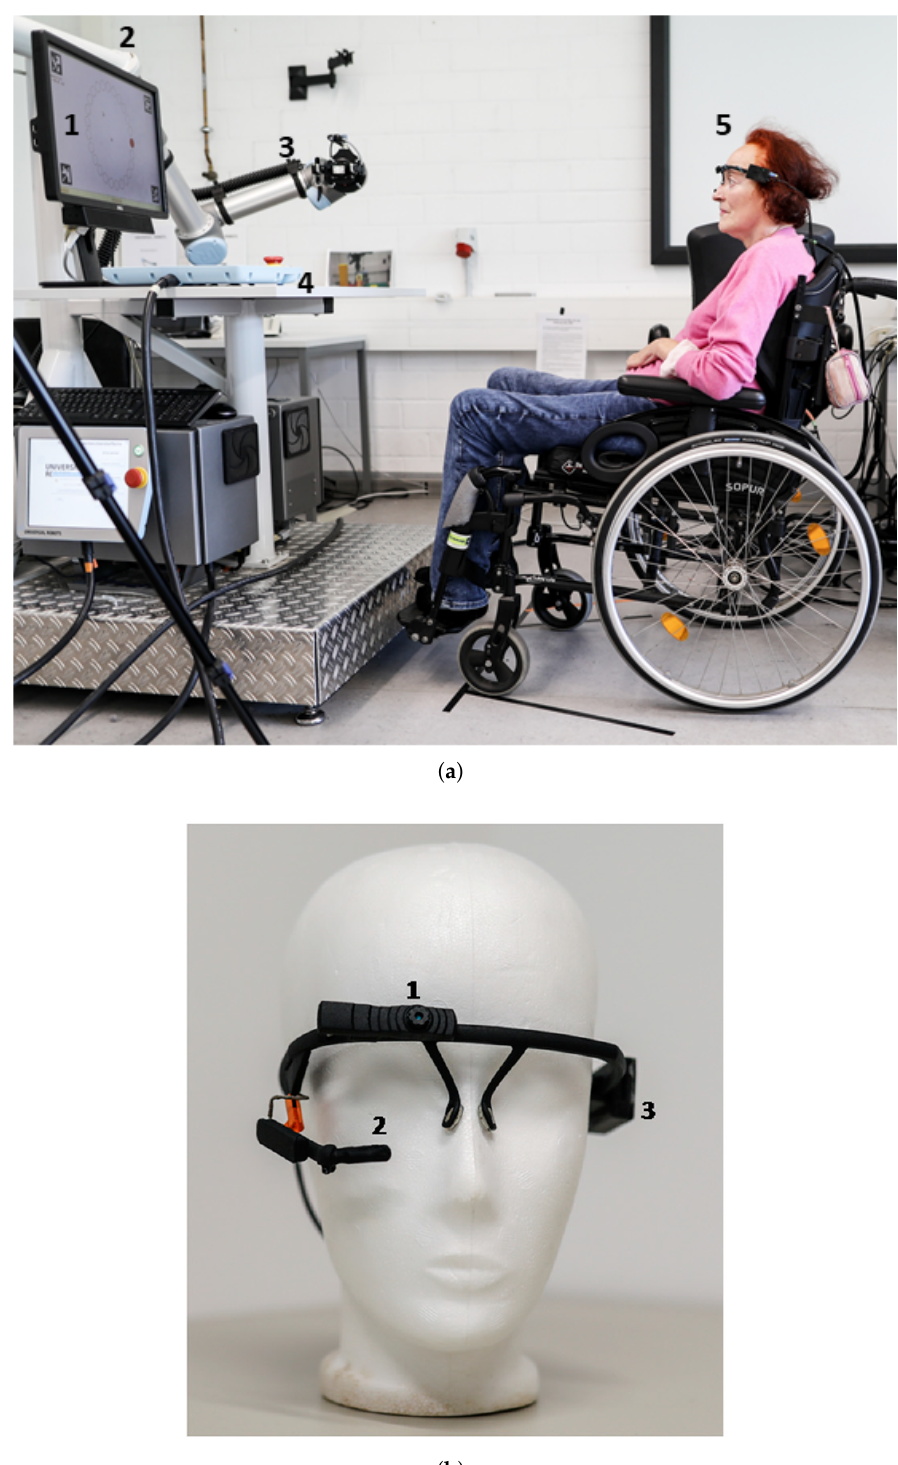
Figure 1. ( a ) Experimental setup with screen to display the GUIs for the tests (1), metal torso (2) on which the robot arm with gripper (3) is mounted, table (4), and subject with the multimodal control unit (5); and ( b ) the multimodal control unit consists of an eye tracker Pupil Core (worldcamera (1) and eye camera (2)) and a MARG-sensor